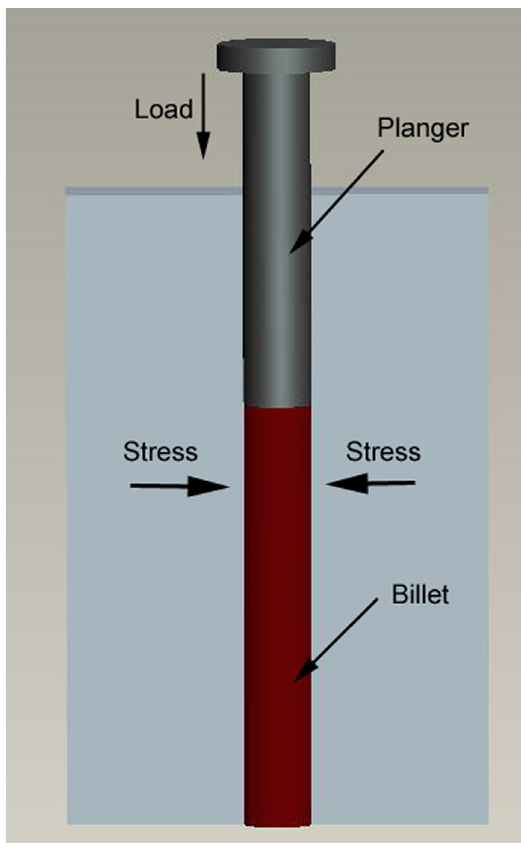
Figure 1. The section view of pre-compression die on Mg alloy billets